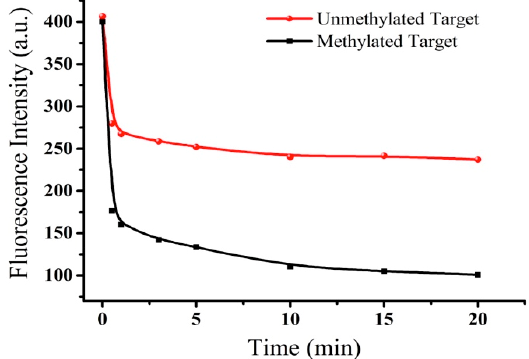
Figure 3. The kinetic behavior of FAM-probe fluorescence quenching in the presence of MoS 2 with the unmethylated target (red) and methylated target (blank), respectively.